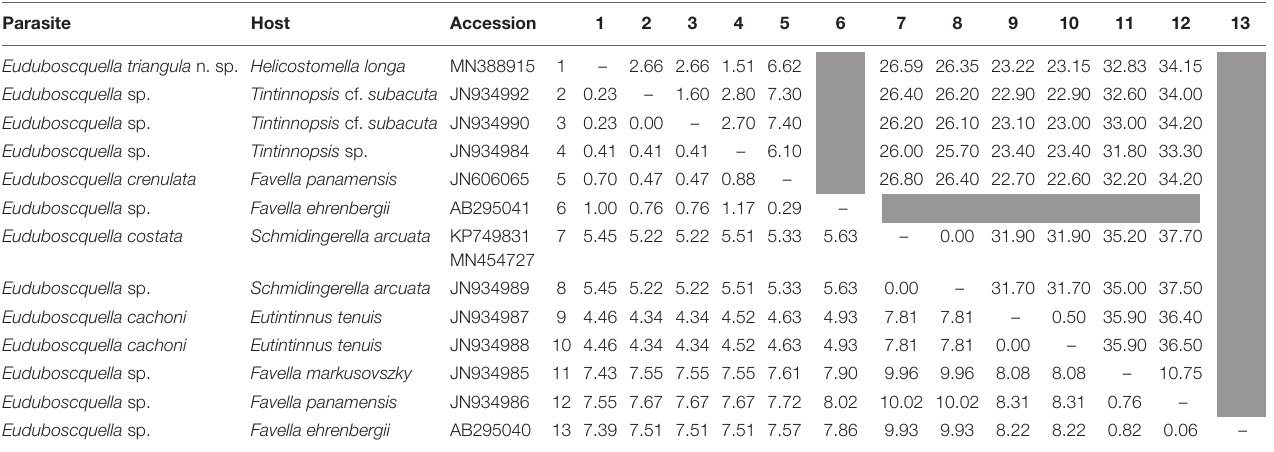
TABLE 1 | Pairwise p -distance values (%) among SSU (1760 bp; bottom diagonal) and ITS1–5.8S–ITS2–LSU (1341 bp; upper diagonal) sequences for Euduboscquella